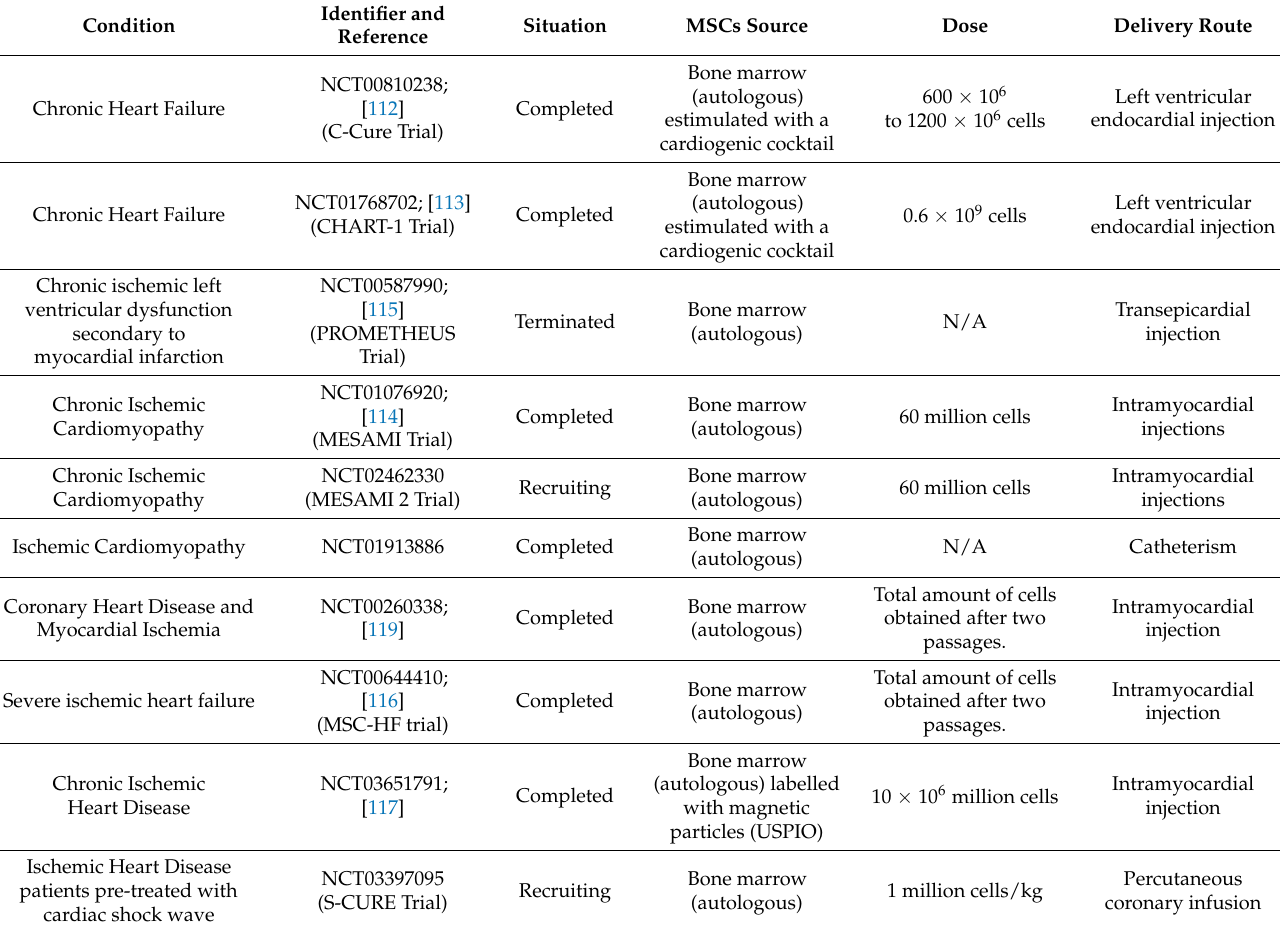
Table 1. MSC-Based Clinical Trials in Heart